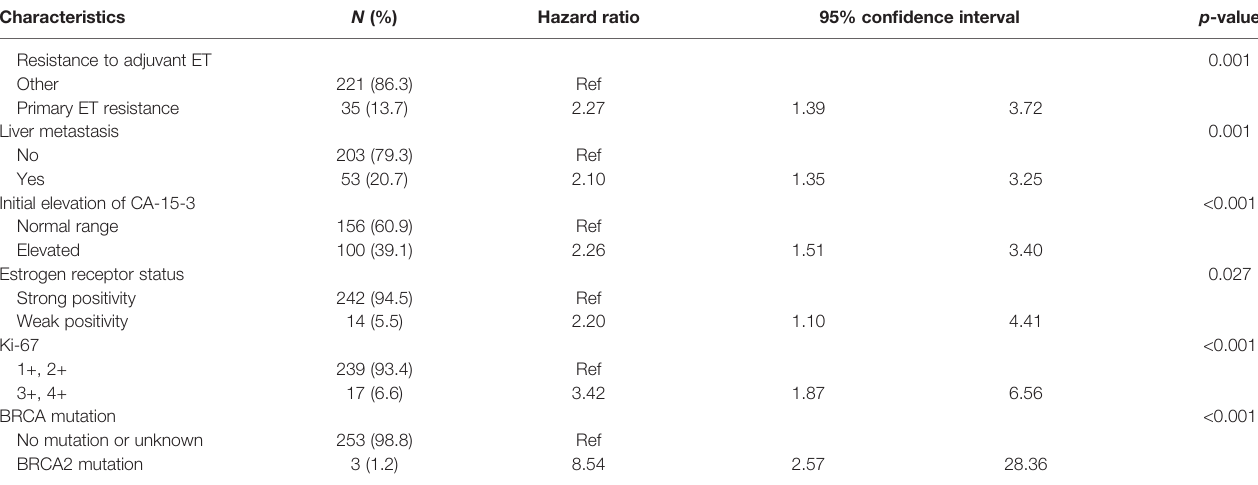
TABLE 2 | Multivariate analysis using binary variables for progression-free survival following palbociclib with letrozole ( N = 256). Characteristics